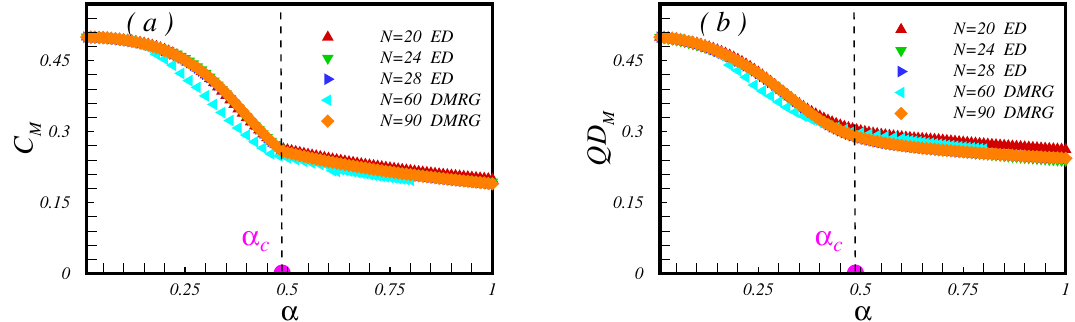
Figure 3. Mean value of the ( a ) the concurrence and ( b ) the QD versus the dimerization parameter. Signature of the quantum critical point is clearly seen in the behaviour of the